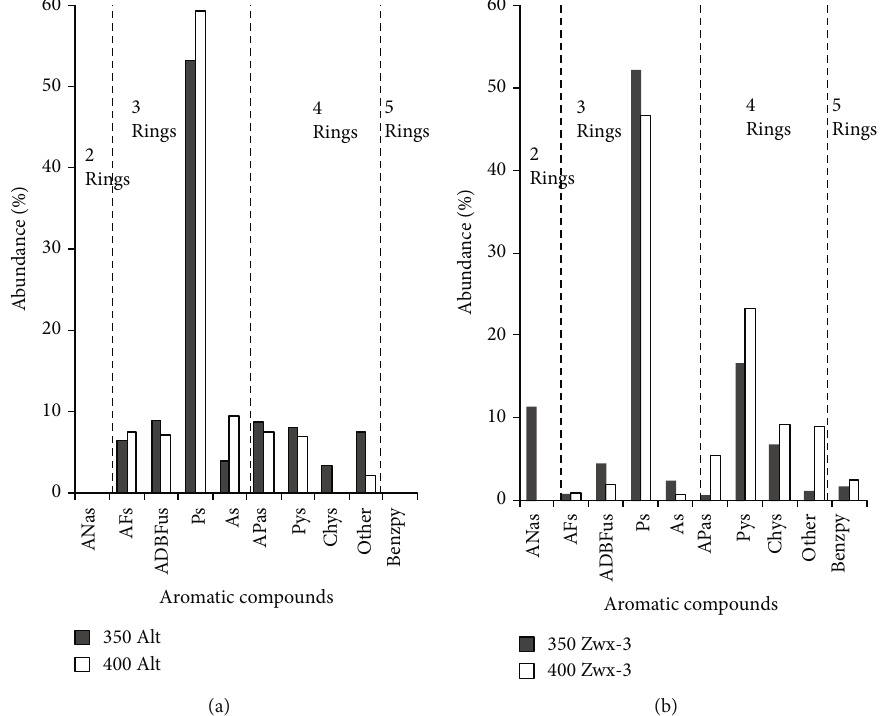
Figure 4: Compositions of PAHs in the Altay (a) and Zhanjiang (b) pyrolysis samples (ANas: alkyl naphthalenes; AFs: alkyl fl uorenes; ADBFus: alkyl dibenzofurans; Ps: phenanthrene and its alkyl homologs; As: anthracene and its alkyl homologs; APas: acephenanthrene and its alkyl homologs; Pys: pyrene and its alkyl homologs; Chys: chrysene and its alkyl homologs; other: fl uoranthene, benz[c]acridine, and benz[a]anthracene; Benzpy: benzo[e]pyrene and